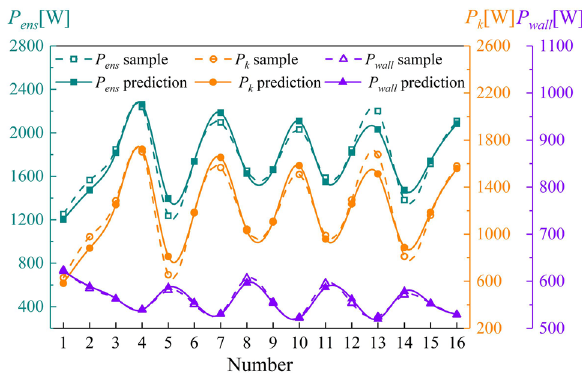
Figure 17. Comparison of sample values and predicted values given by multiple regression